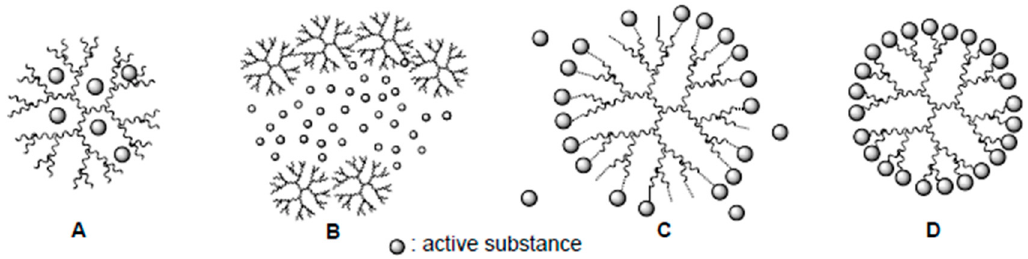
Figure 16. Molecular structures of drugs either encapsulated or stabilized by dendrimers as of 2010. Reprinted with permission from [60]. Copyright 2010 American Chemical Society.